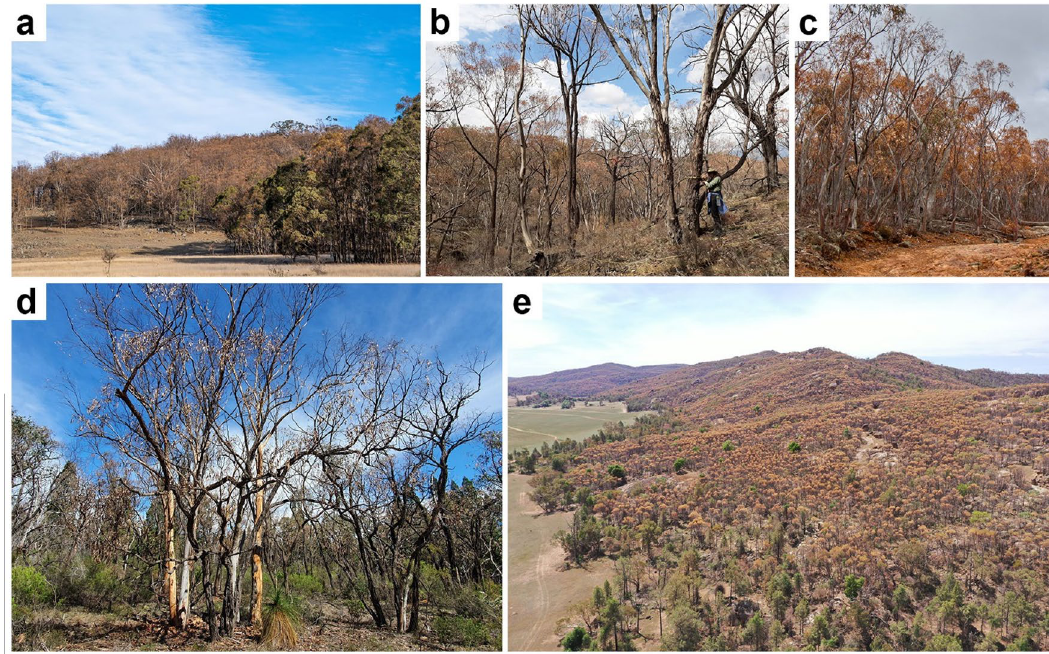
Figure 1. General view of some of the study sites exhibiting extensive canopy dieback: ( a ) Mt Duval, ( b ) Billywillinga, ( c ) Mt Ainslie, ( d ) Munghorn Gap National Park, and ( e ) Eugowra Nature Reserve (see Table 1 for site locations). Photos were taken between November 2019 and February